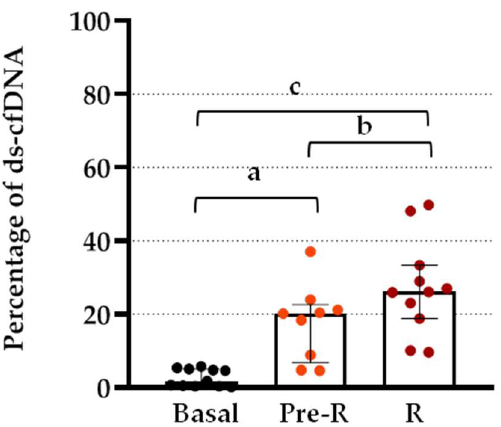
Figure 3. Differences in serum ds-cfDNA levels at BPR and previous to BPR from patients after TX. Percentage increase in serum ds-cfDNA in patients after TX at BPR (R) and 2–3 days before BPR (pre-R) compared to basal levels. Boxes represent median and inter-quartile ranges, and whiskers show 5th–95th percentile. ANOVA test p < 0.0001. Analysis between groups by post hoc Bonferroni test; (a) p = 0.001; (b) p < 0.05; (c) p < 0.0001.